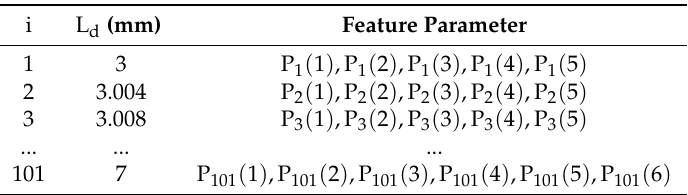
Table 3. Feature parameters at various L d